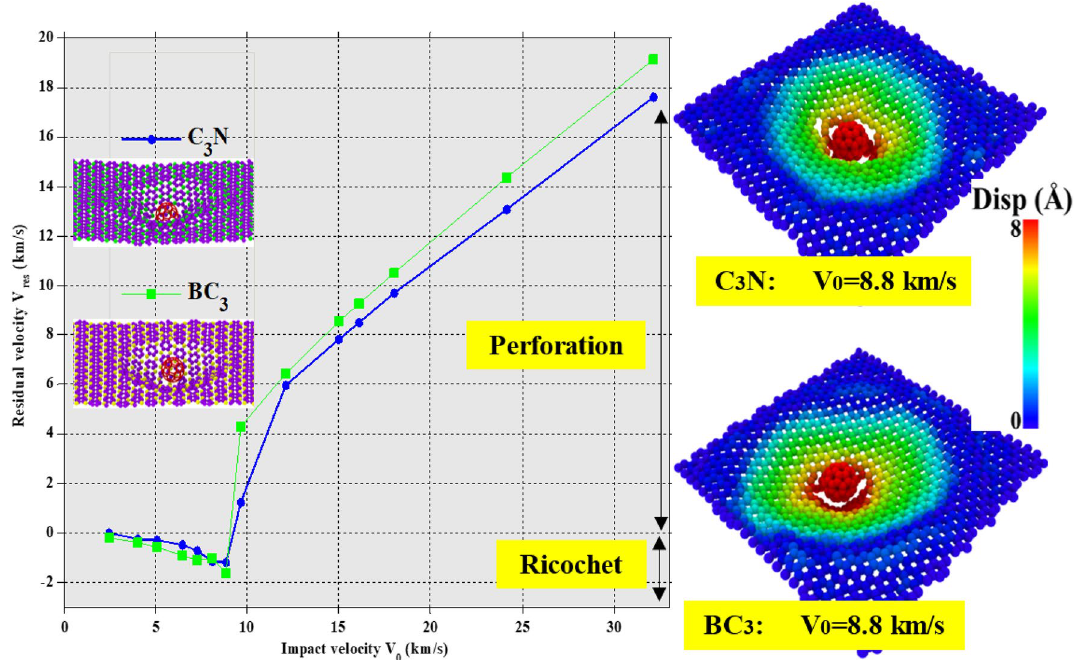
Figure 2. Left panel: Ballistic curves of single-layer C 3 N and BC 3 . The residual velocity V res is referred to as the average velocity of the C 60 atoms in the Z direction. Right panel: configurations of C 3 N and BC 3 at the 8.8 km/s initial velocity of C 60 with MD simulation. The color of each atom indicates its displacement. For visual clarity, the color bar is limited up to 8 Å, and the same color shows all displacements beyond this